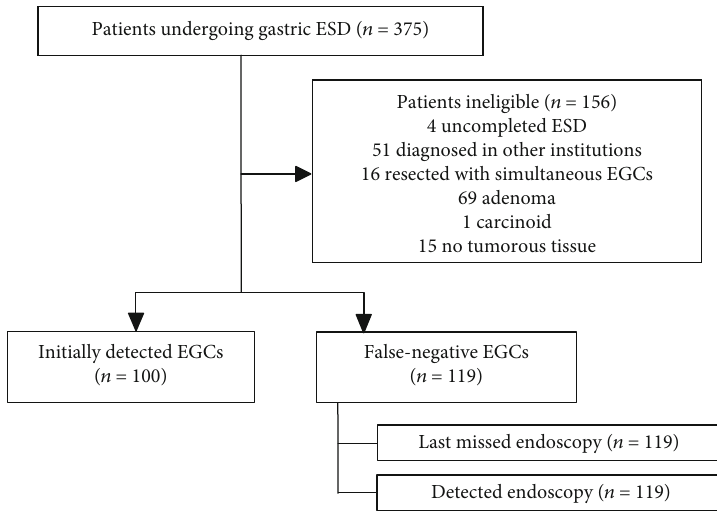
Figure 2: Assignment pro fi